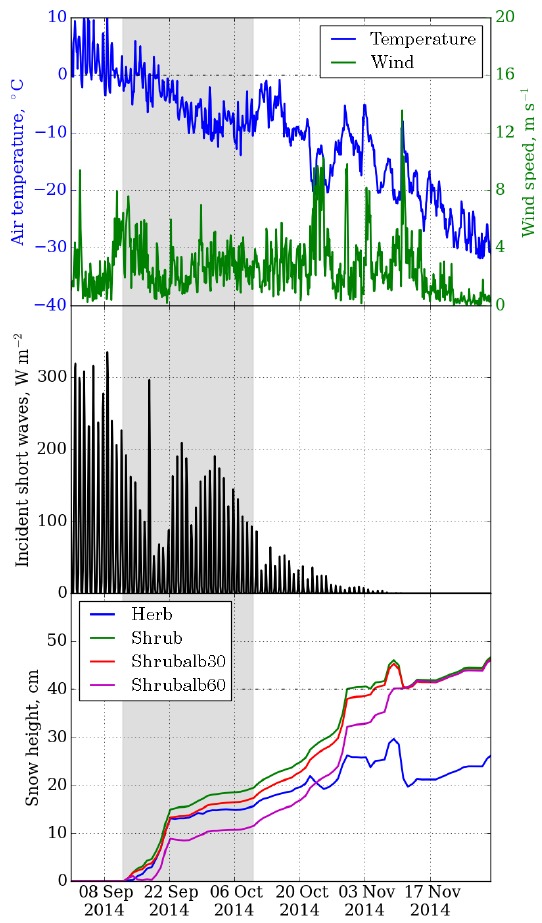
Figure 9. Air temperature, wind speed, incoming shortwave radi- ation and snow height in fall 2014. The shaded area indicates the period when snow is affected by albedo decrease.